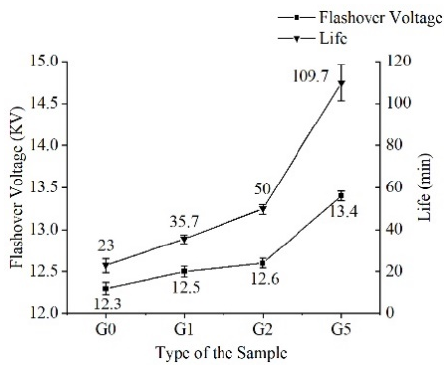
Figure 14. High-frequency surface insulation strength.